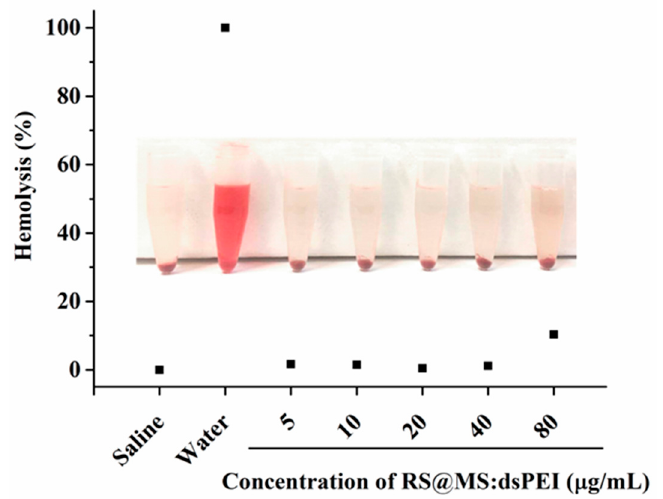
Figure 9. Hemolysis assay of RS@MS(Dox):dsPEI, using water as positive control and saline as a negative control.